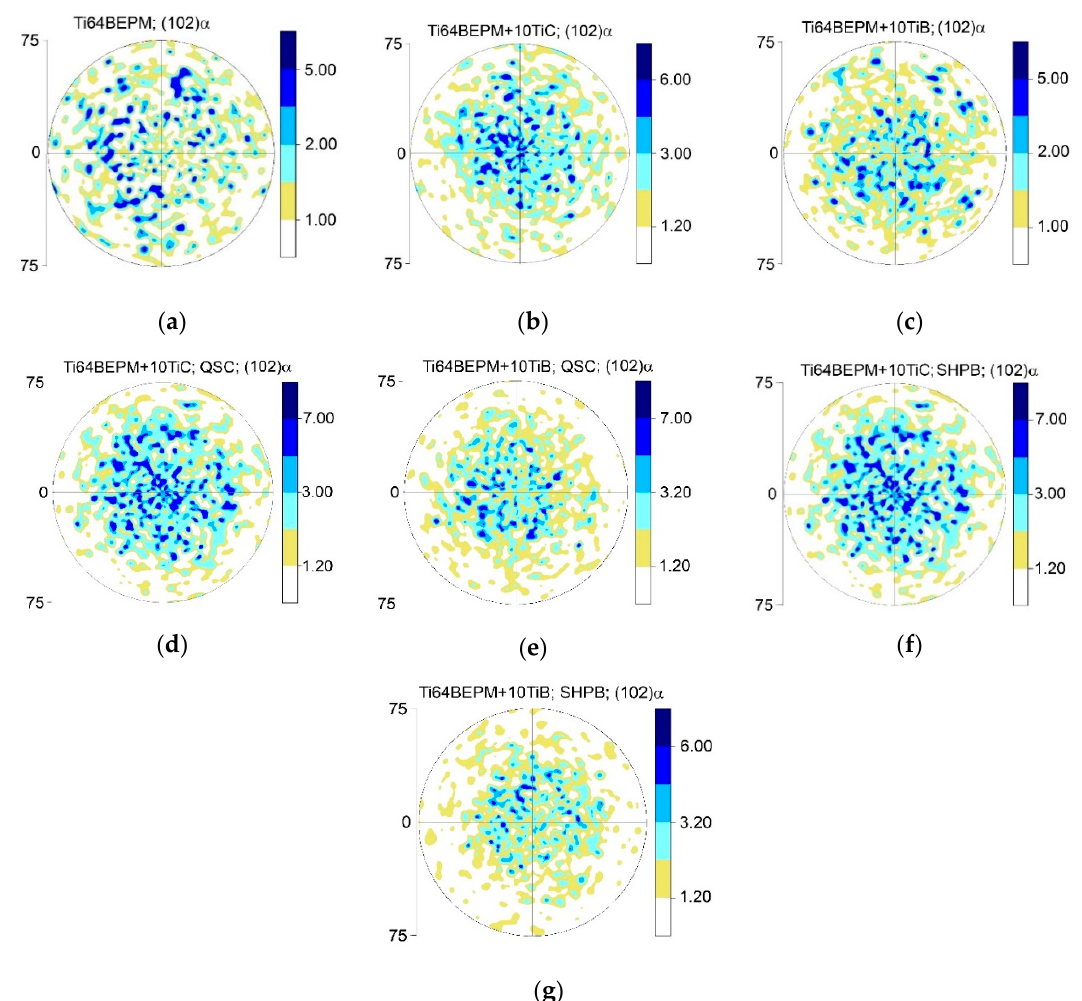
Figure 4. The pole figures (102) α of Ti64BEPM ( a ), Ti64BEPM + 10TiC ( b , d , f ), and Ti64BEPM + 10TiB ( c , e , g ); in initial (as- sintered) state ( a – c ), and after quasi-static ( d , e ), and high-strain rates ( f ) 1550 s − 1 , and ( g ) 2050 s − 1 compression.